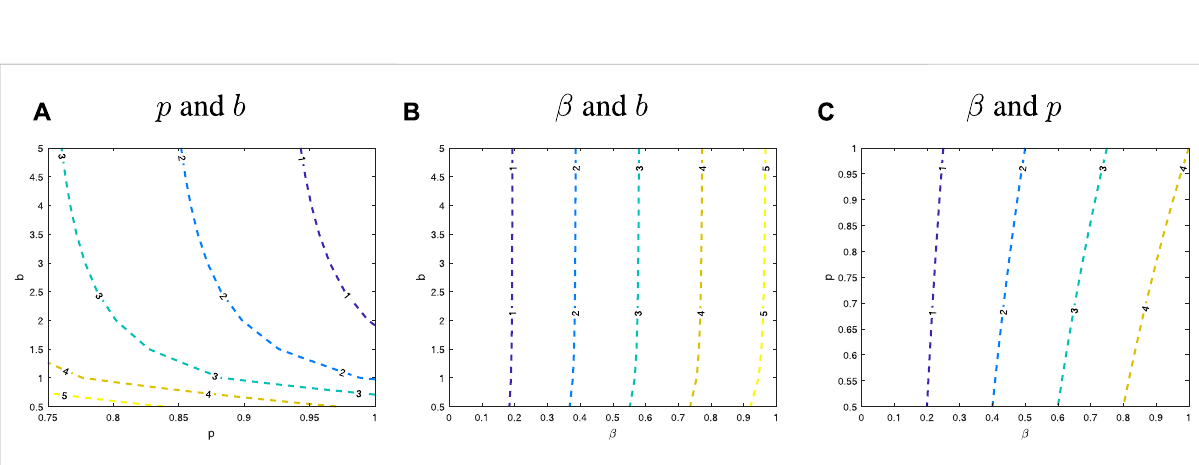
FIGURE 10 Sensitivity analysis of two parameter of β , b and p . The different colored dashed line shows the different values of the control reproduction number and parameters are numerical values of type B-7. (A) is sensitivity analysis of p and b, (B) is sensitivity analysis of β and b, and (C) is sensitivity analysis of β and p.